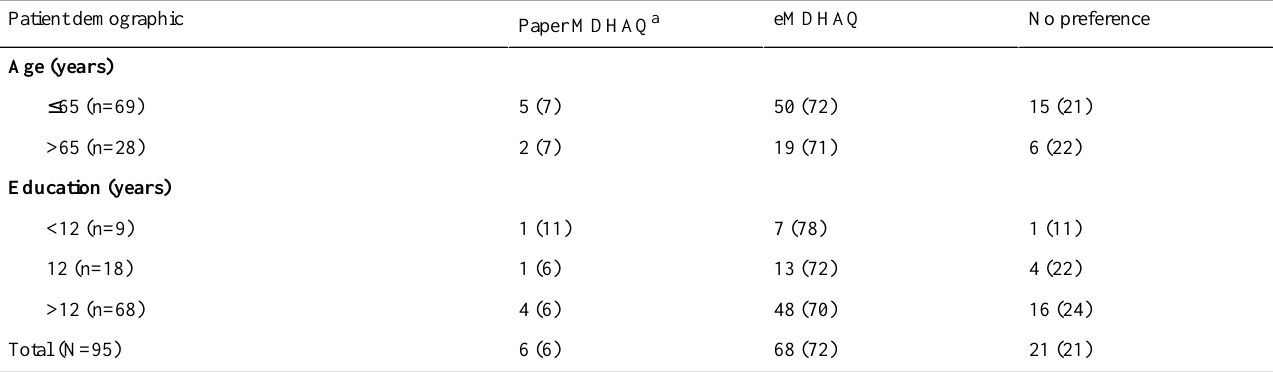
Table 3. Preferred version of the MDHAQ according to patient age and education level, n